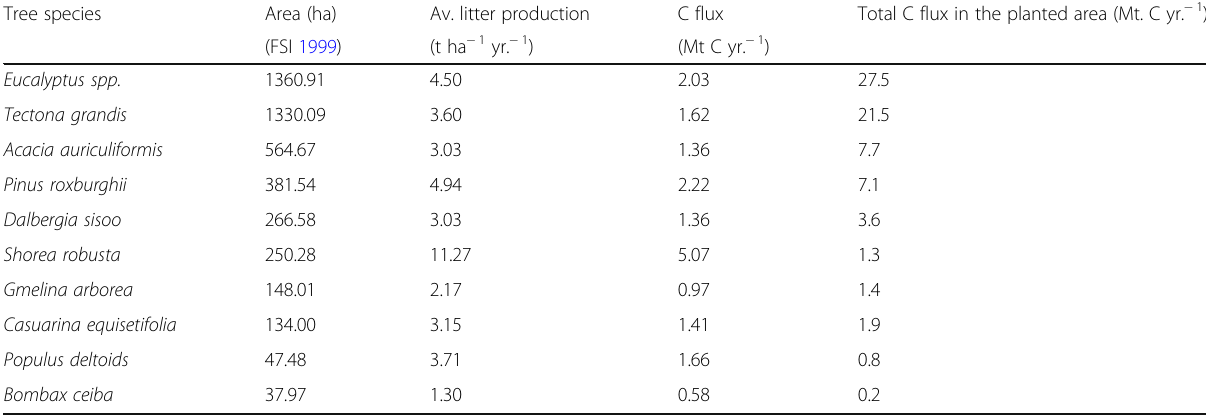
Table 3 Estimated rate of carbon flux in selected planted forests in India Tree species Area